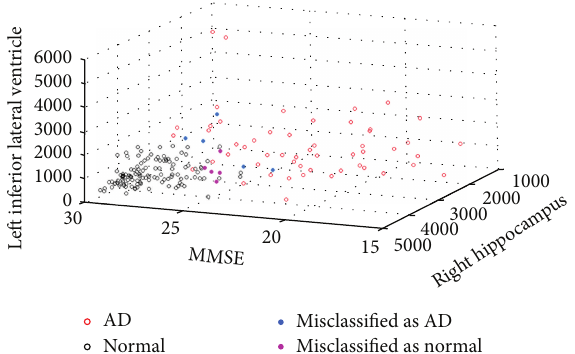
Figure 5: Representation of the whole dataset for the “MMSE + subcortical volume” model, for a typical classification run under this